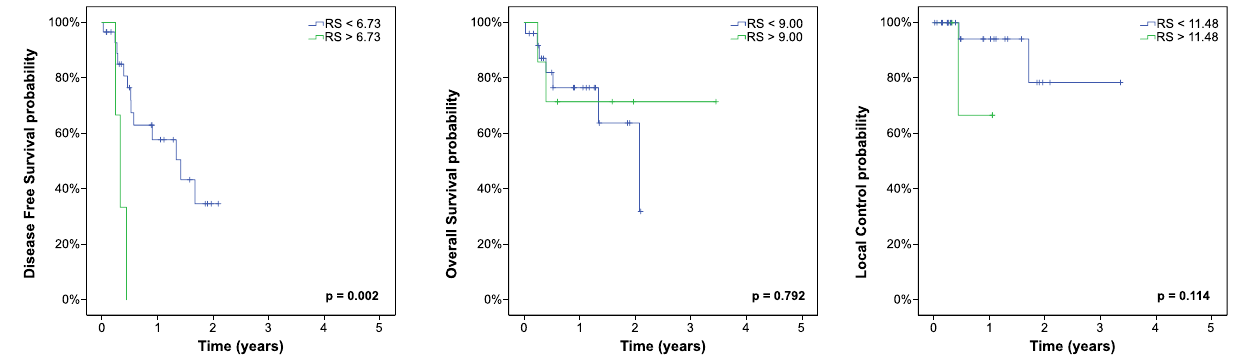
Figure 3. External validation cohort. Kaplan–Meier estimates with prognostic groups split by endpoint-specific radiomics signatures (RS) into high and low-risk population.